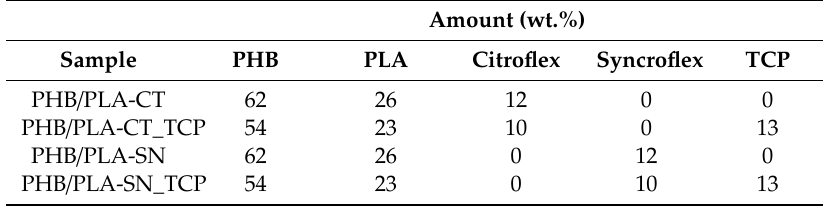
Table 1. The composition of prepared samples: the basic mixture is composed of 12% of plasticizer and the remaining 88% is PHB / PLA in the ratio of 70 / 30. For filled samples, 15 wt.% of TCP is added to the